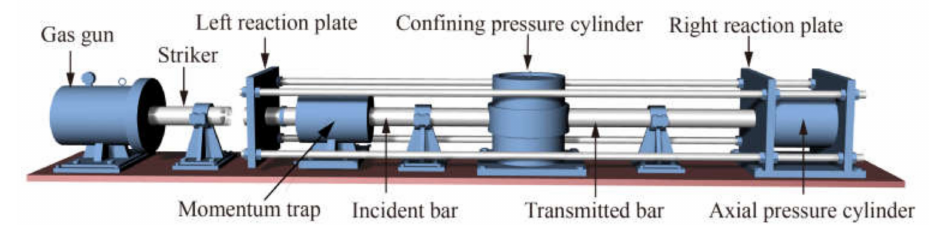
Figure 4. Schematic diagram of